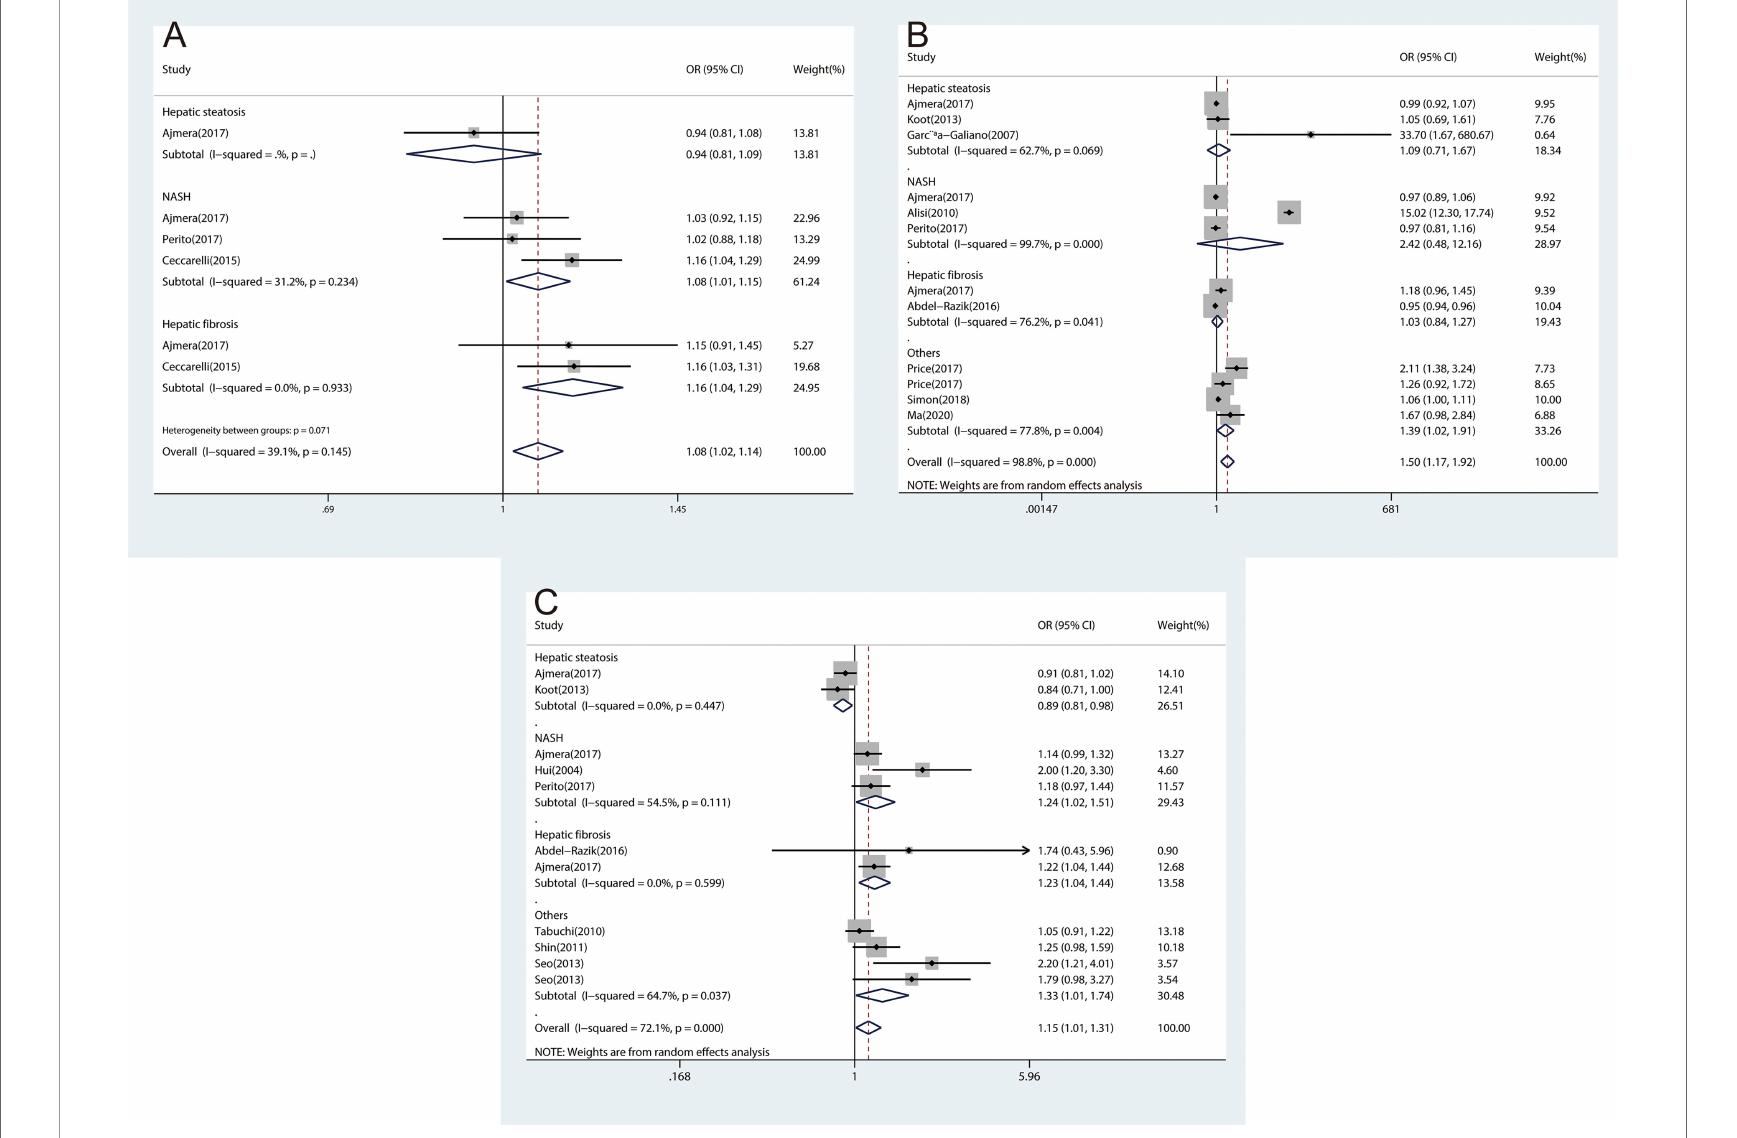
FIGURE 4 | The forest plots of the association between in fl ammatory cytokines and subtypes of NAFLD. (A) , Association between IL-1 b and subtypes of NAFLD. (B) , Association between IL-6 and subtypes of NAFLD. (C) , Association between TNF ‐ a and subtypes of